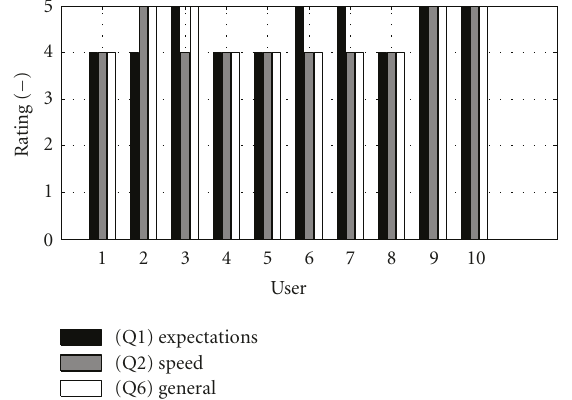
Figure 5: Actual ratings of the questionnaire (Q1, Q2, and Q6) for all users at location 2 (high signal strength).